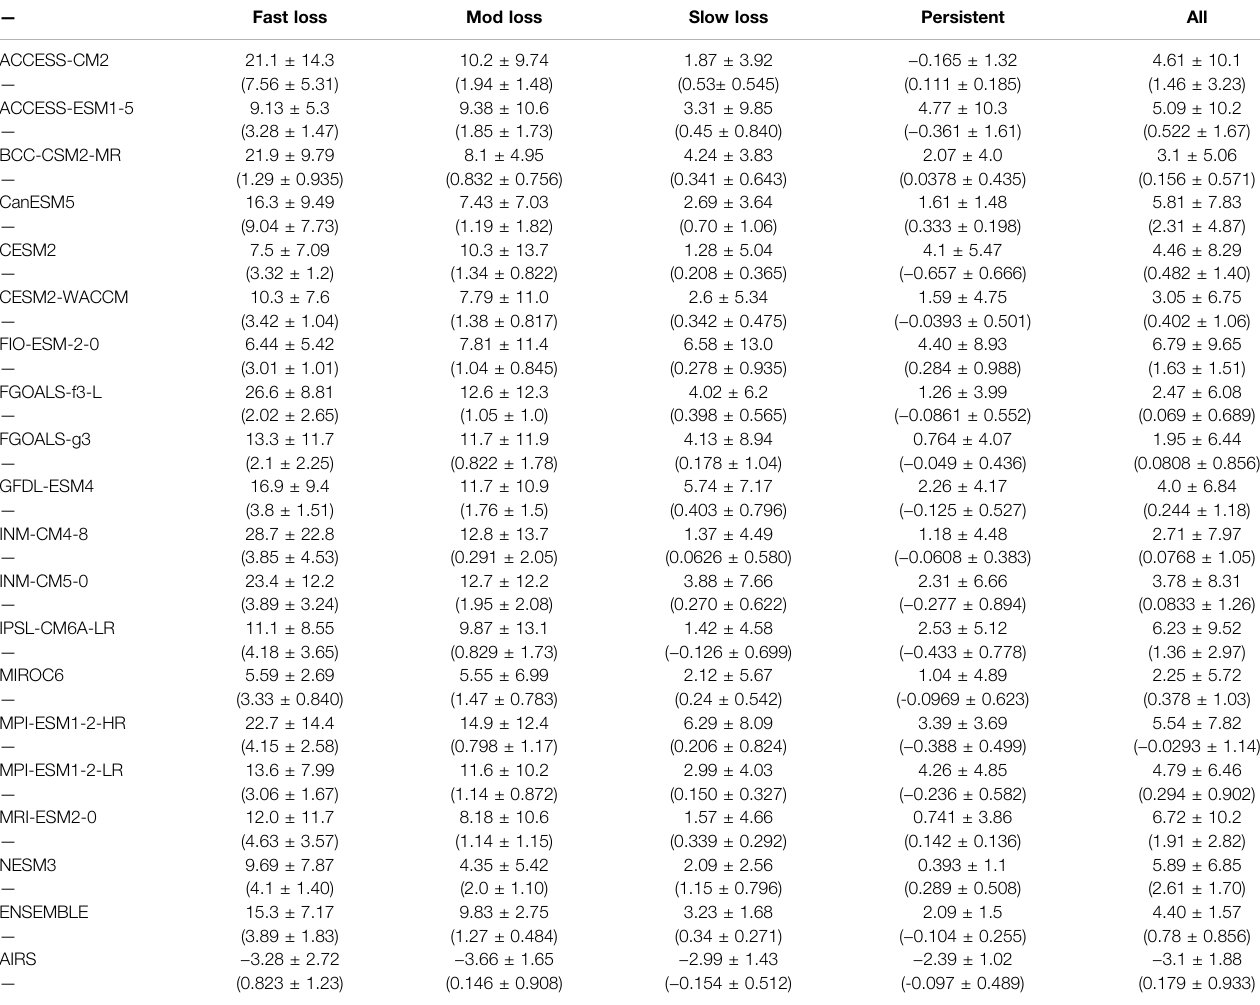
TABLE 3 | Summary of mean values and their standard deviation (decadal trends and their standard deviations in parenthesis) for AIRS-derived and CMIP6 models LHF for October-January 2002 – 2020. Values are strati fi ed by Arctic sea ice loss regimes regions.